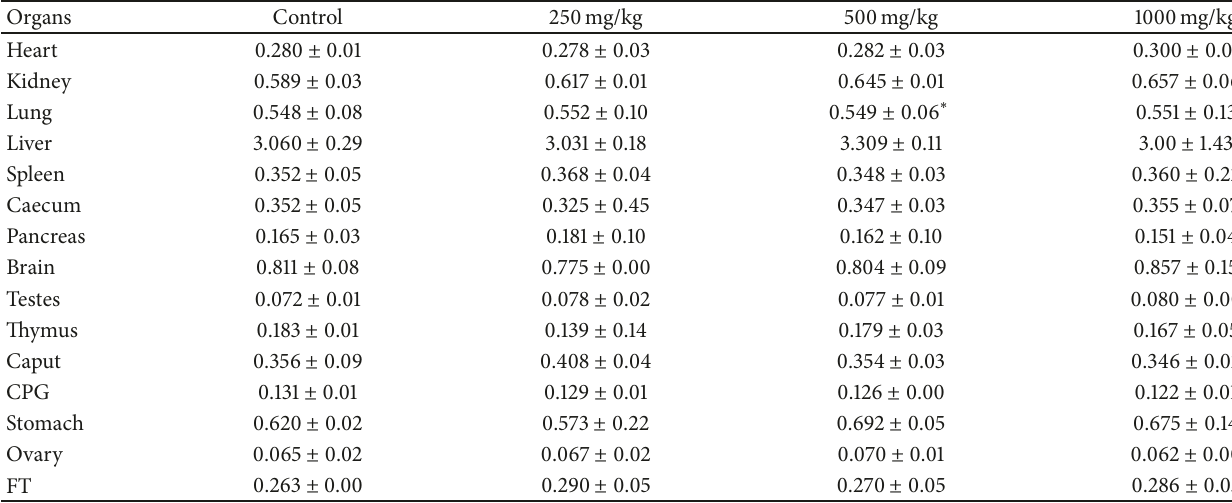
Table 2: The effects of different concentrations of methanolic extract of pomelo on the relative organ weight. Organs